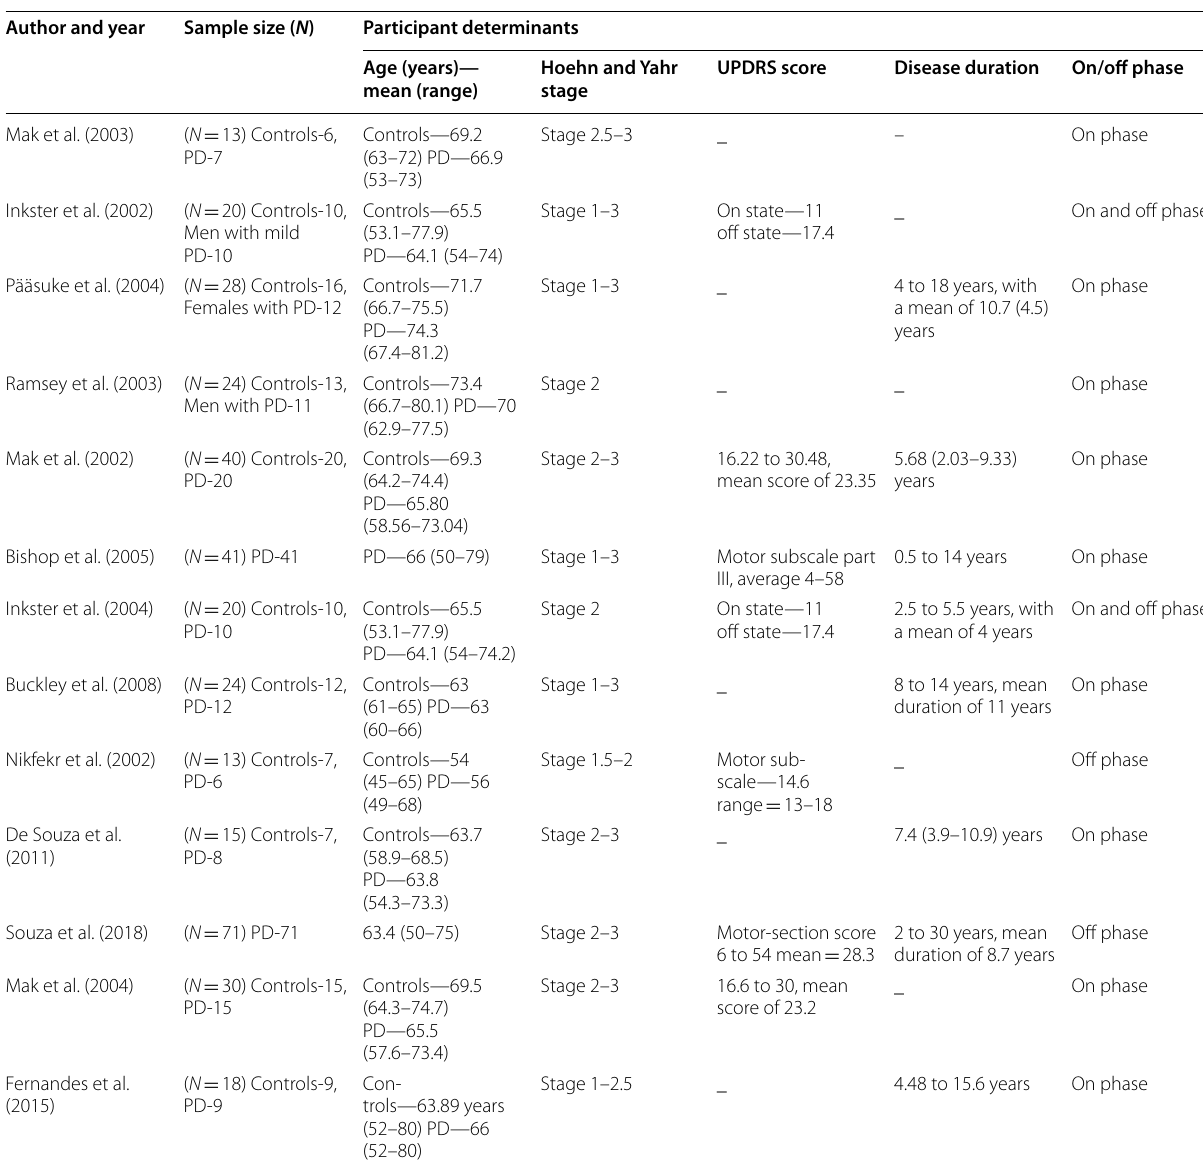
Table 1 Participant